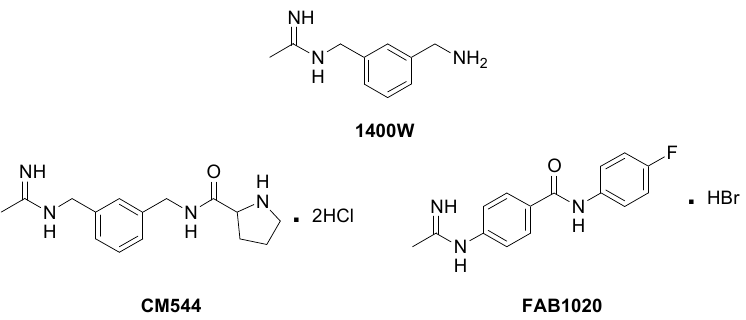
Figure 1. Chemical structure of 1400W, CM544 and